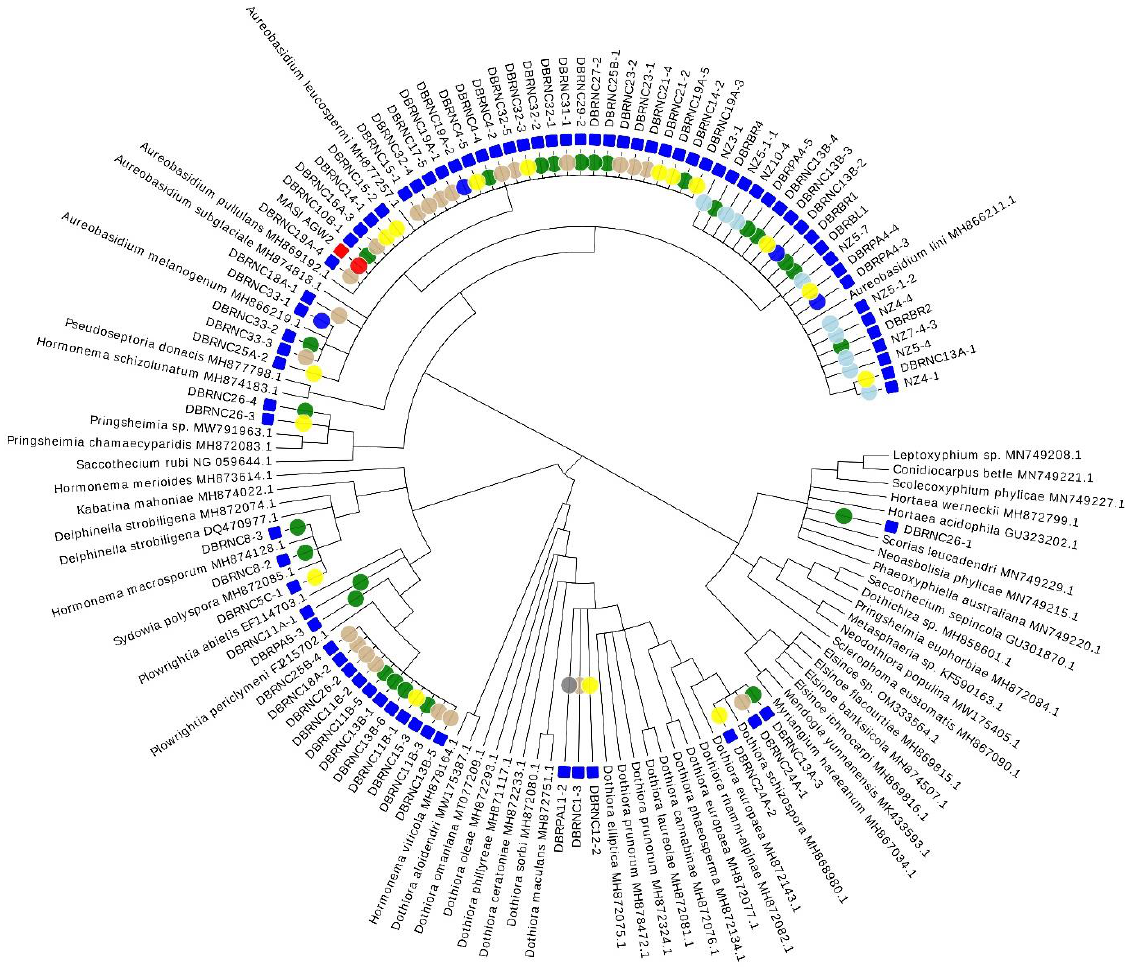
Figure 3. Cladogram of cultured lichen-associated Dothideomycetes isolates showing the distribution of isolates obtained across different isolation media. Cladogram reconstructed from LSU alignment, GBLOCK analysis, and PhyML tree reconstruction. Visualization conducted using EvolView 2. Blue squares represent isolates obtained via liquid enrichment strategies; red square represents isolates obtained via direct plating methods; taxa with no information are class representative taxa. Circles represent isolation medium: red circle = direct plating; green circle = acidified malt broth; tan circle = xerophilic broth; blue circle = monoterpene; pink = nitrogen free; light blue = Nikkomycin Z; yellow = high osmotic broth; grey = saline swab.